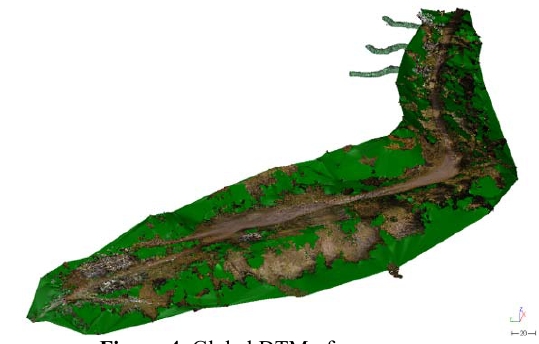
Figure 4 : Global DTM of quarry area.